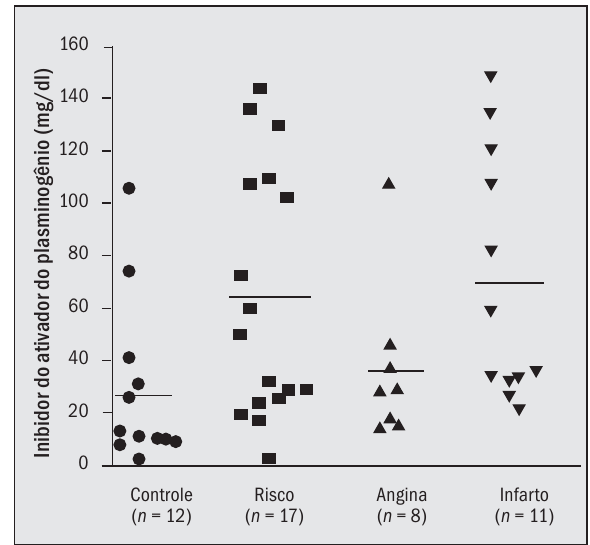
Figura 4 – Resultados dos níveis plasmáticos do inibidor do ativador do plasminogênio tipo 1 nos grupos estudados. As barras horizontais indicam o valor médio encontrado para cada grupo ( n = número de amostras). Não foi observada diferença entre as médias dos grupos